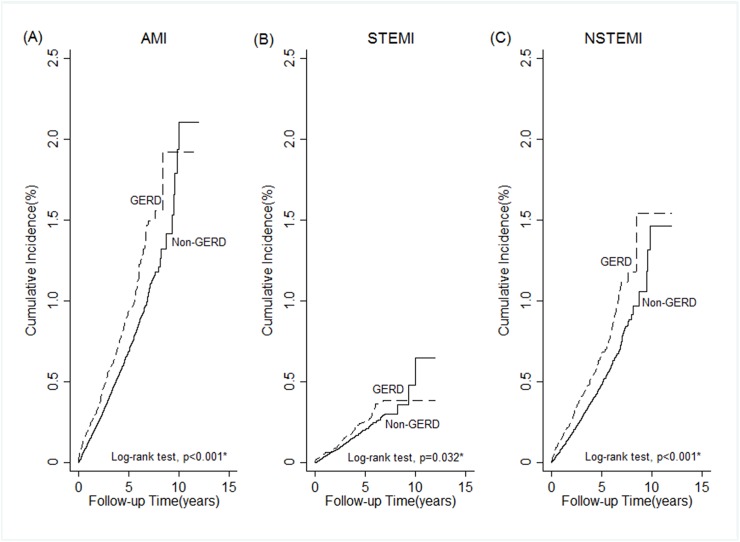
Kaplan-Meier curves showing a significant difference in cumulative incidence of acute myocardial infarction (AMI) among patients with GERD and controls.